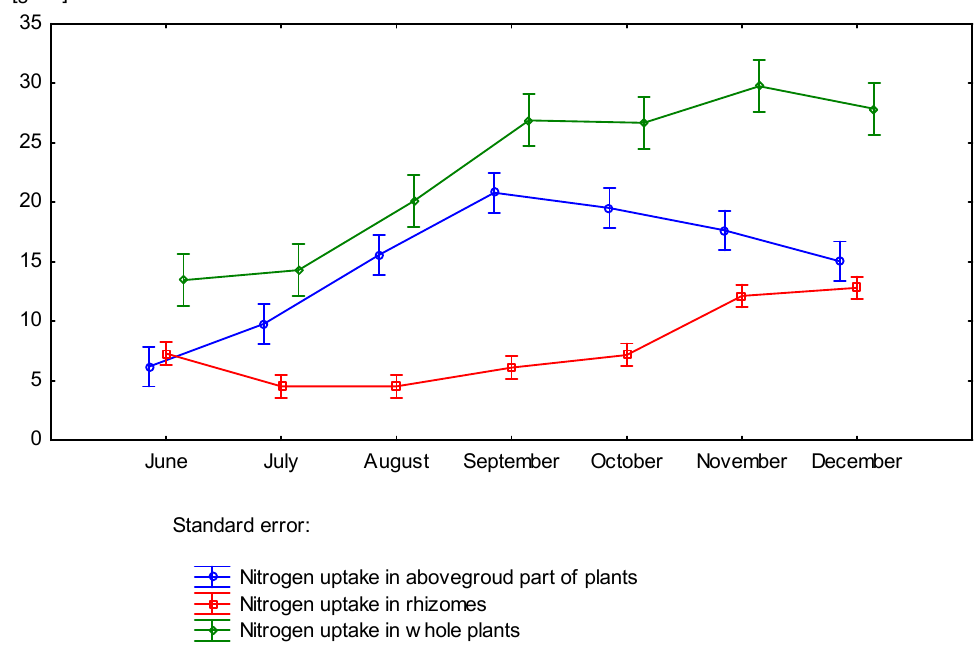
Figure 10. Nitrogen uptake by the whole plants (average for years).